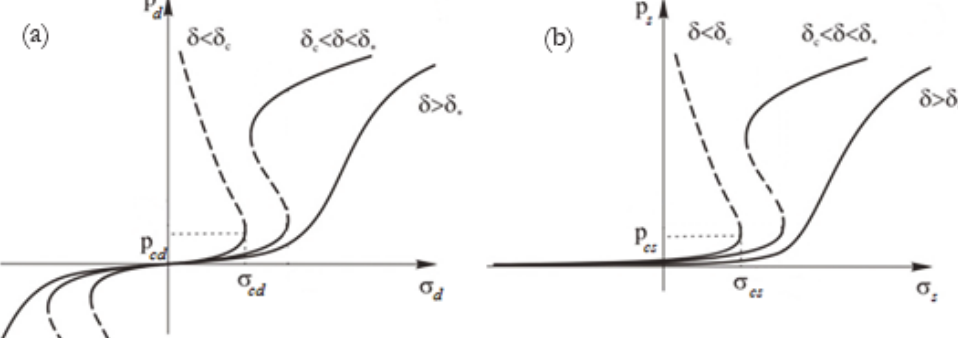
Figure 1: Characteristic material reactions on the growth of defects: (a) - for microshears, (b) - for microcracks